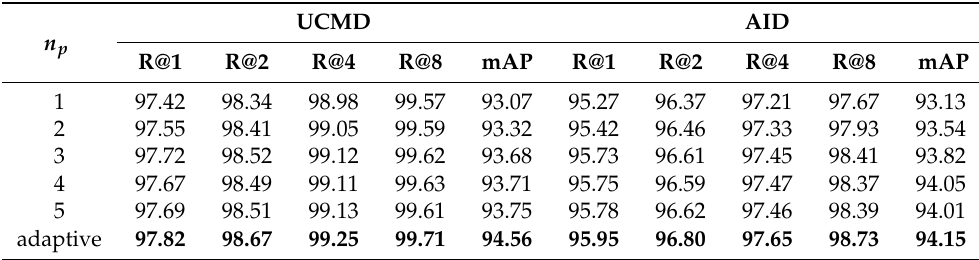
Table 5. Validation of the number of proxy and adaptive proxy methods on UCMD and AID. The best results are shown in bold.